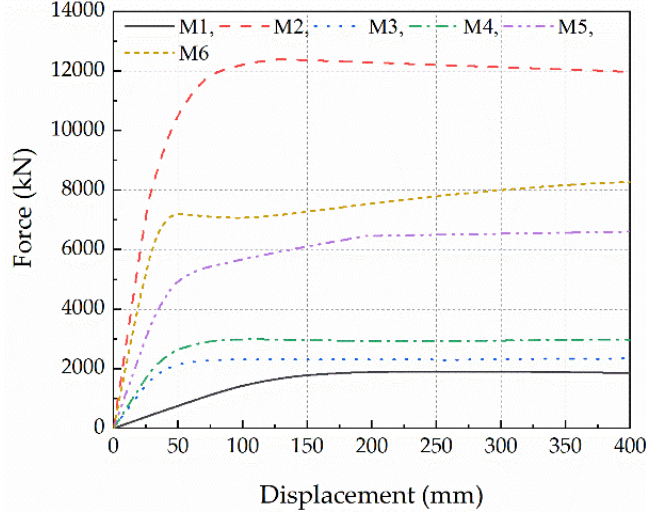
Figure 8. The base shear-displacement curves of six models.